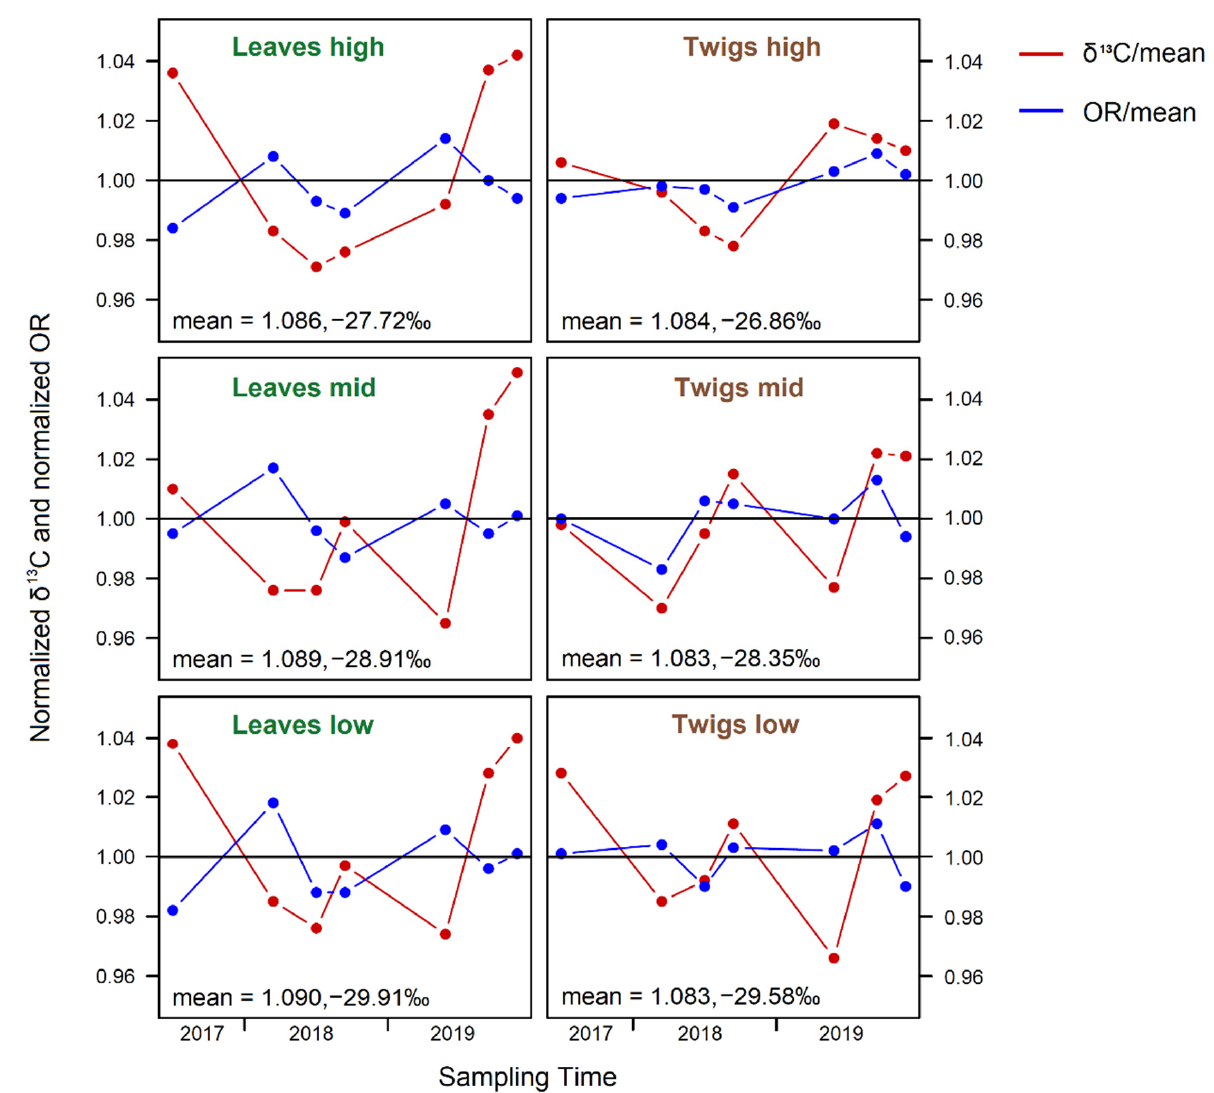
Figure 3. Normalized carbon isotopic composition ( δ 13 C) and oxidative ratios of leaves and twigs for three heights (24, 28 and 32 m) and 7 sampling times. For each panel the mean is taken from the 6 times from May 2018 to October 2019, and then every value is divided by the mean to show the deviation from the mean.In contrast to δ 13 C, we found no effect of sampling height on ORs in twigs and leaves (Figures 3 and 4) This means, while the isotopic composition changes vertically with canopy position reflecting vertical changes in microclimate, the stoichiometry of the elements (C, N, O, H) is not affected by the location when looking at the same component.